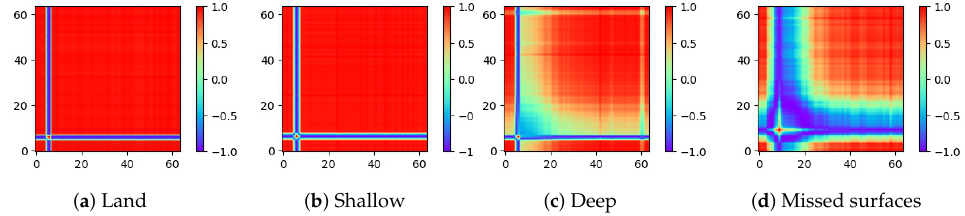
Figure 7. Diagram of different transform methods used for the bathymetry